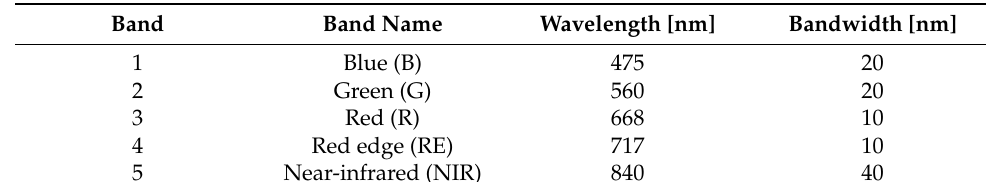
Figure 3. ( a ) The UAV in operation; ( b ) the RedEdge multispectral camera; ( c ) the calibration panel showing the known reflectivity value for each of the bands recorded. Table 1. The parameters of the bands recorded by the RedEdge camera.